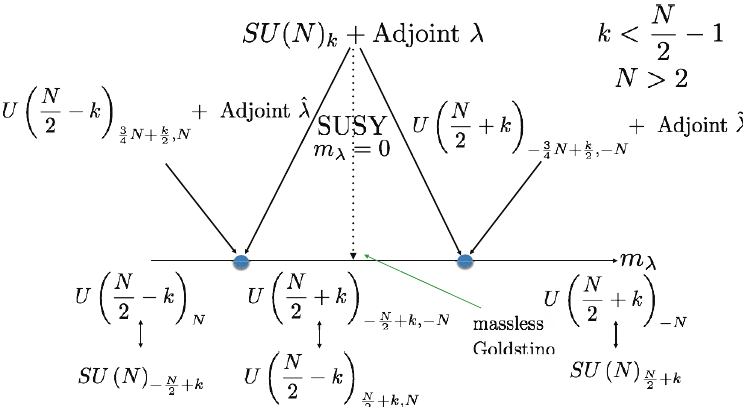
Figure 7: The phase diagram of SU ( N ) with an adjoint fermion and k < N / 2 − 1 and k N > 2. In this theory there are two transitions where the infrared TQFT has to change and in addition one point where the Goldstino becomes massless, in between the two transitions. A fermionic dual for both of the nontrivial transitions is